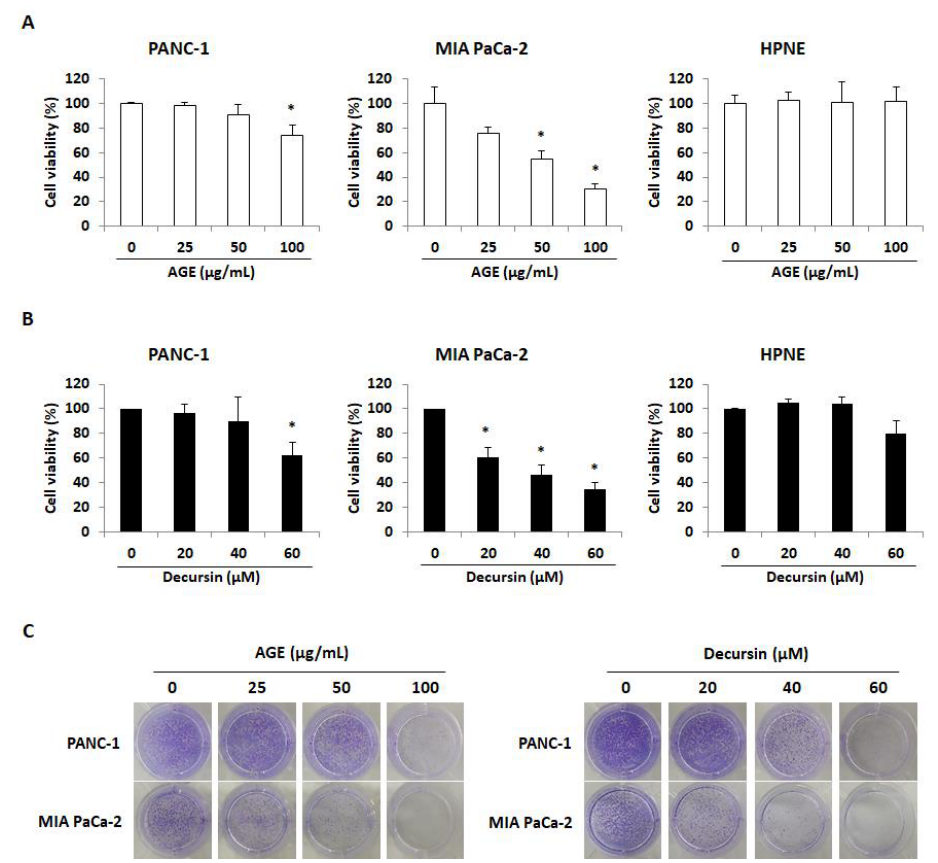
Figure 1. ( A ) Chemical structure of decursin. Ultra-performance liquid chromatography (UPLC) chromatograms of Angelica gigas Nakai ethanol extract ( B ) and the standard decursin ( C ).